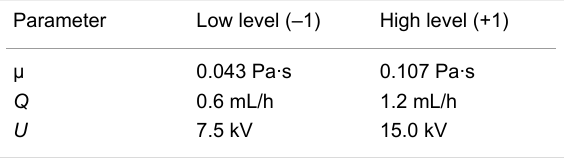
Table 3: Process variables selected for the factorial analysis of bead size and fiber diameter in the fibrous mats with bead-on-string struc-